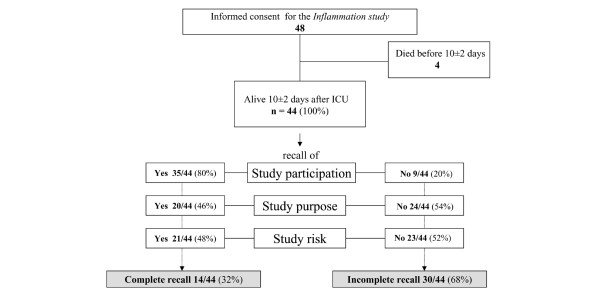
Distribution of the patients.